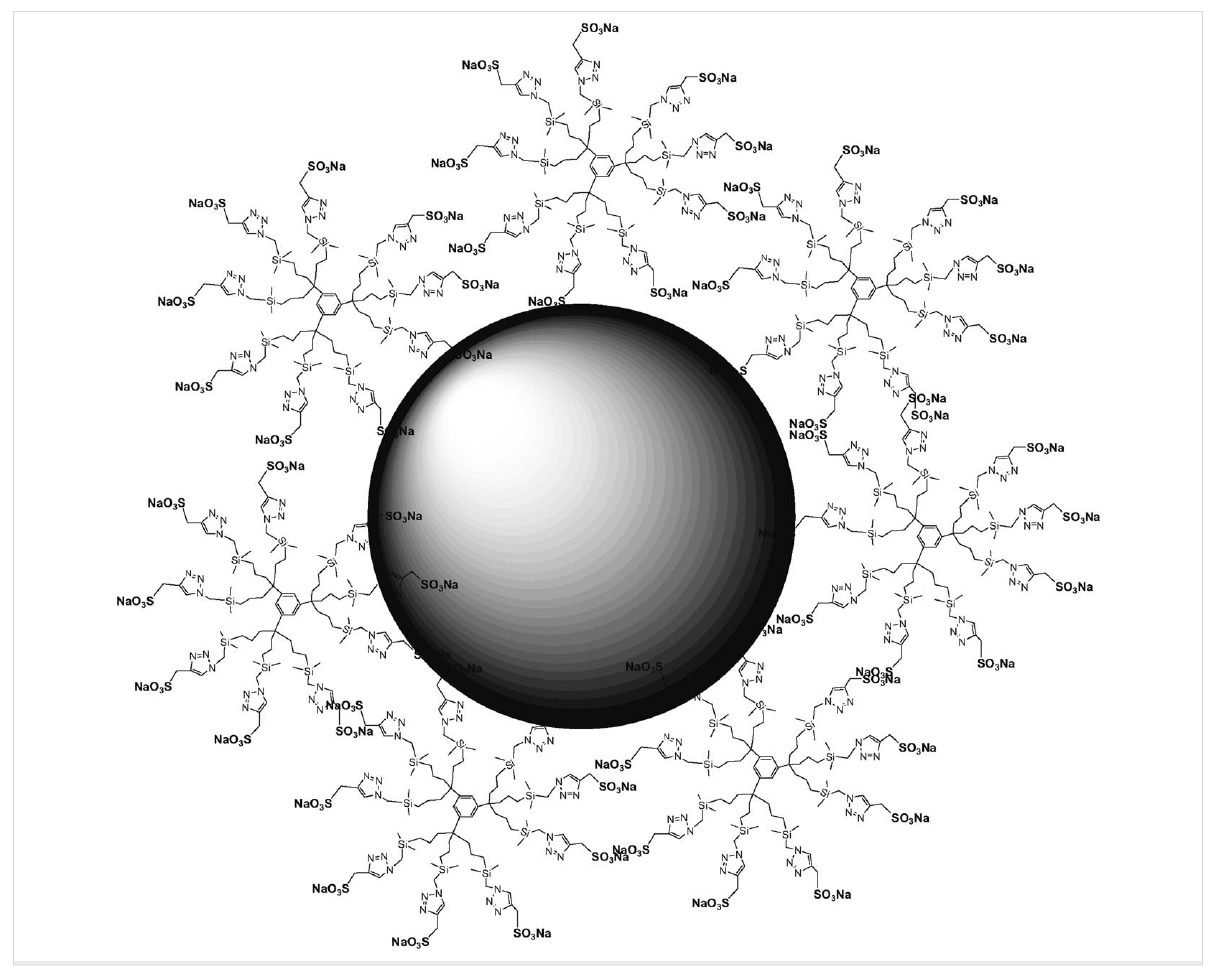
Figure 6: Representation of DSN-G 0 . Reprinted with permission from